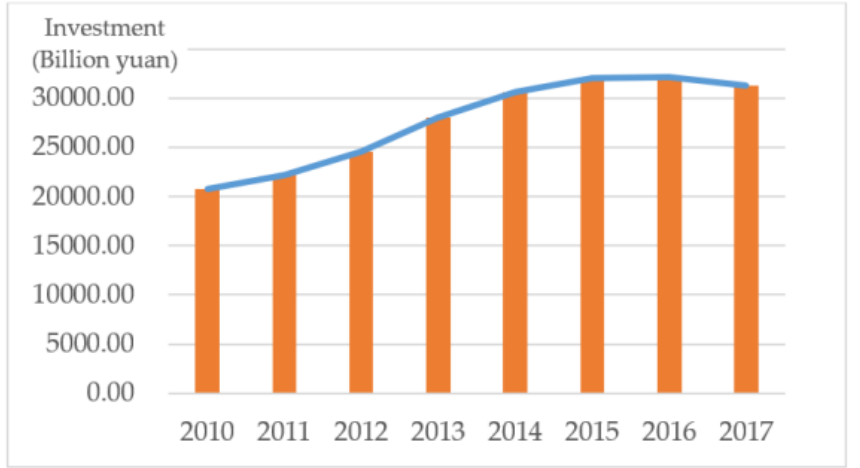
Figure 1. 2010–2017 National Energy Investment Figure 1. 2010 – 2017 National Energy Investment Amount.